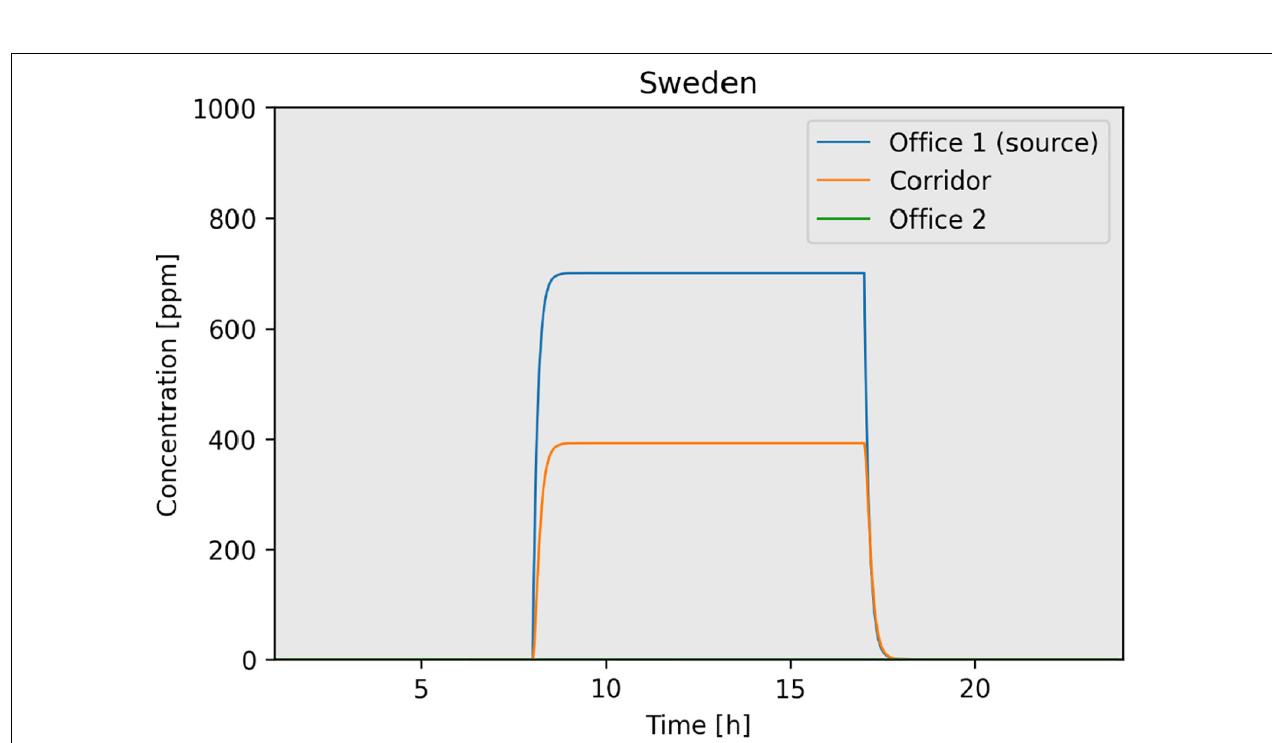
FIGURE 9 | Concentration of contaminants in typical Swedish office buildings (background concentration excluded).